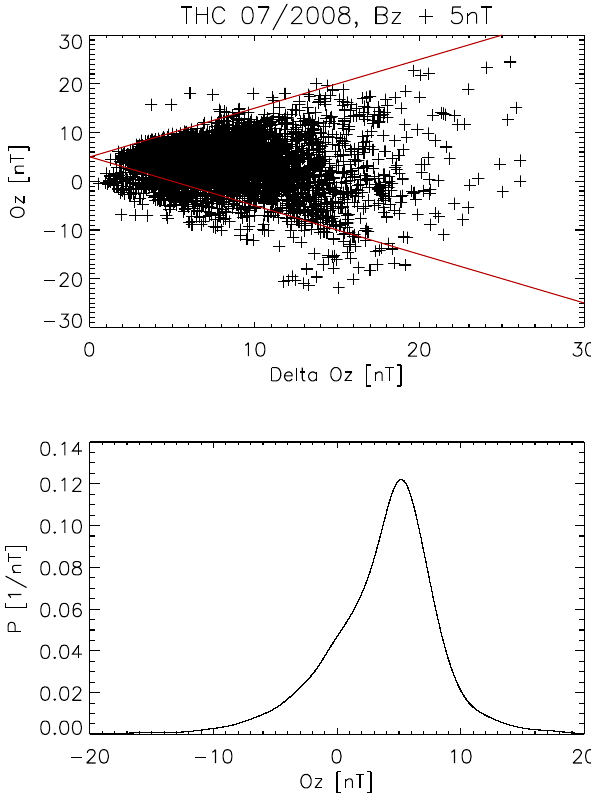
Figure 4. Same as Fig. 3 but determined from THC FGM measure- ments to which 5nT were added in the B z component. Red lines in the top panel depict O z = ± (cid:49)O z +